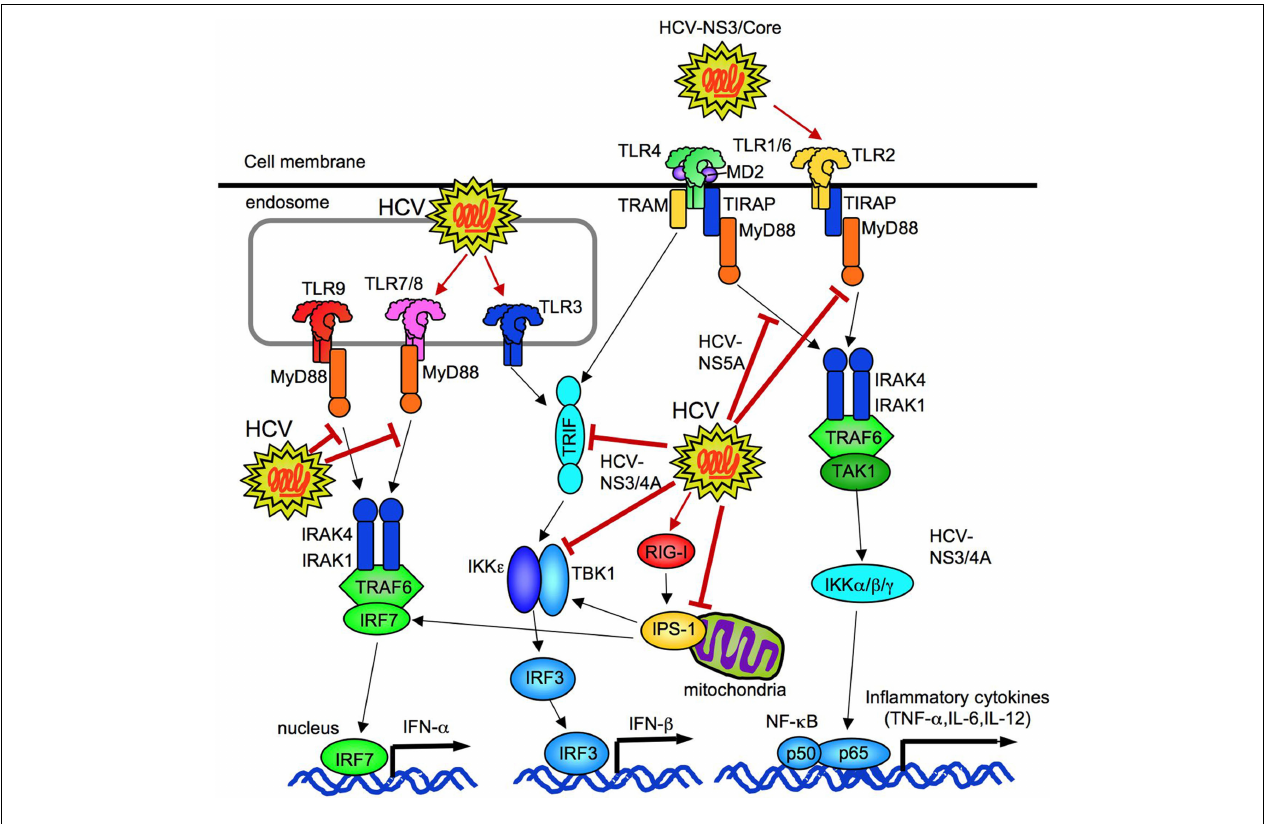
to MyD88 to preventTLR2, 4, 7, and 9 signaling. HCV (NS3/4A) cleaves of IPS-1 at C508, resulting in prevention of IRF3-mediated IFN- β